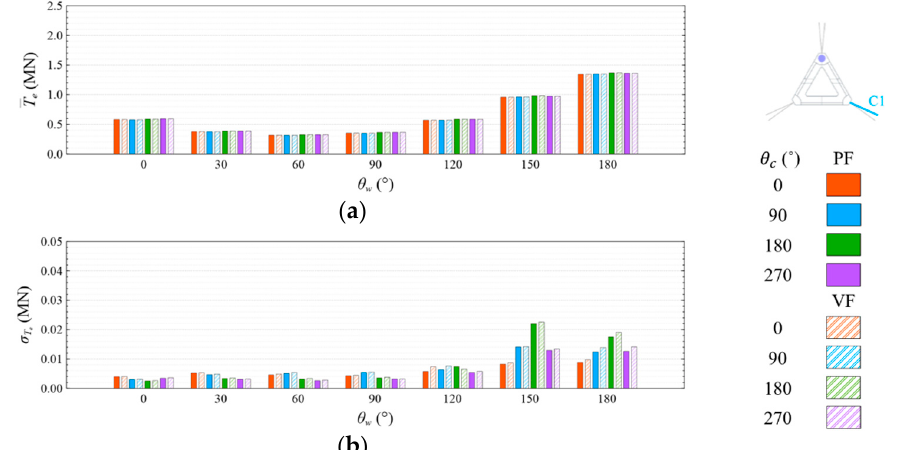
Figure 32. Comparison of ( a ) means and ( b ) standard deviations of mooring line tension of Line C1 under CW condition.